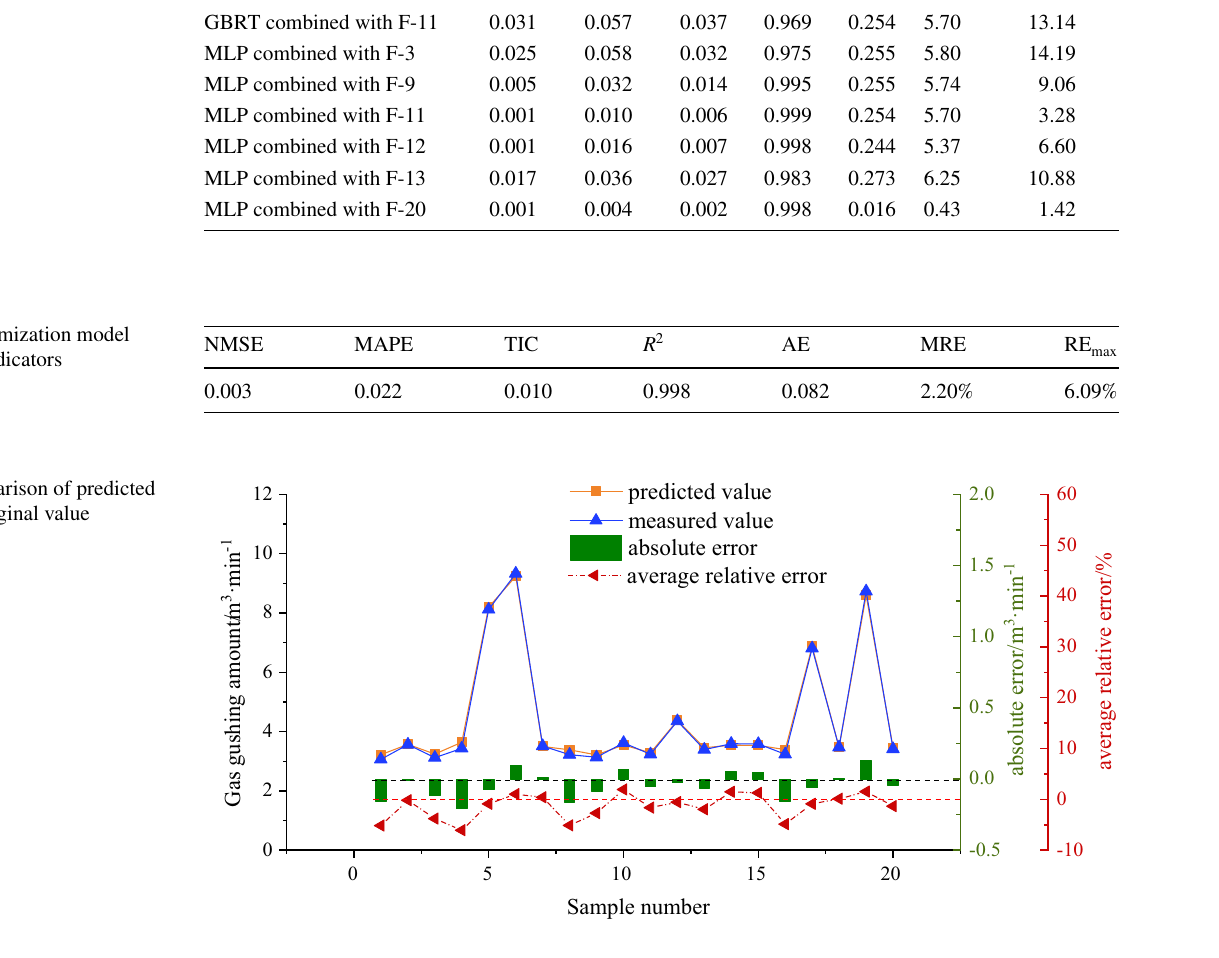
Table 3 Evaluation indexes of model prediction results